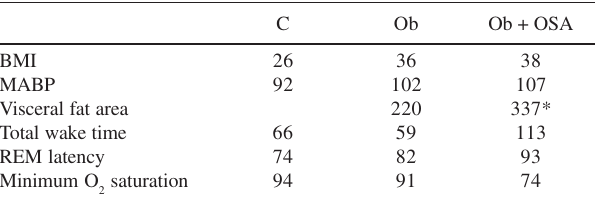
Table 1 - Additional effects of obstructive sleep apnea (OSA) on metabolic and vascular parameters in obesity. Data on control (healthy) subjects and obese patients without OSA are also shown (adapted from ref.